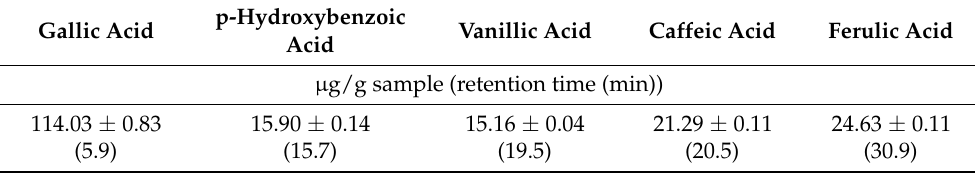
Table 2. The content of free phenolic compound in SBP extract.